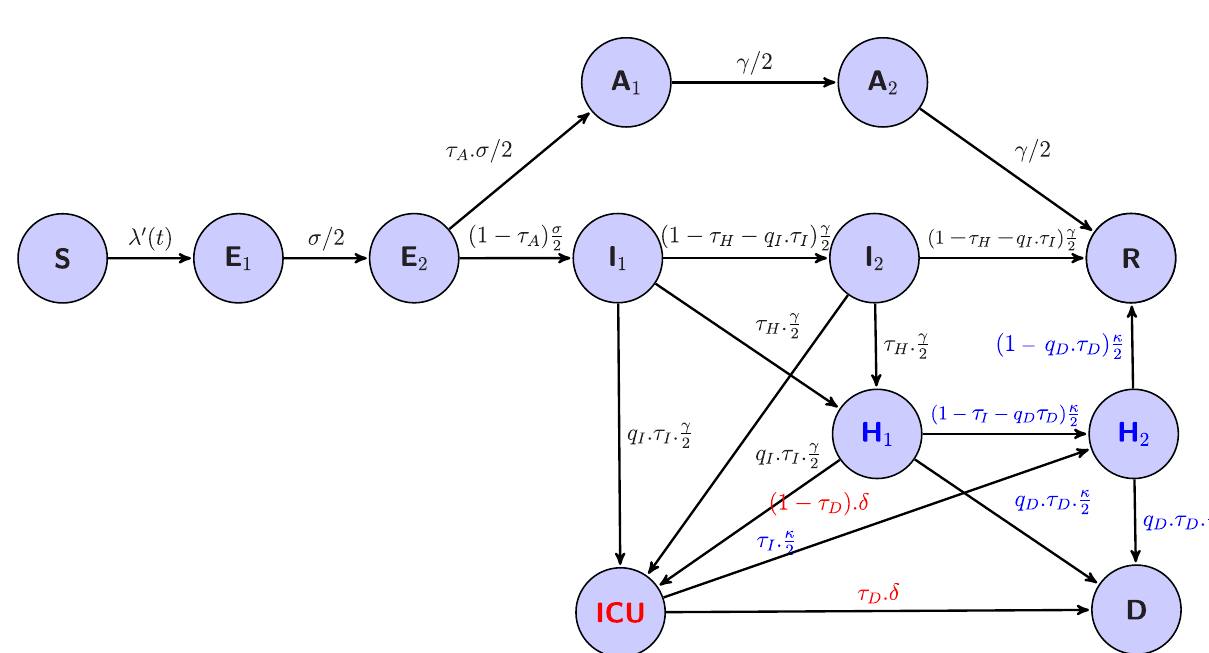
Fig 1. Flow diagram of a generalized SEIR model accounting for asymptomatic transmission and a simplified hospital system (see S2 equations in S1 Text). The variables are: the susceptibles S , the infected non-infectious E , the infectious symptomatic I , the infectious asymptomatic A , the removed individuals R , and the hospital related variables: the hospitalized individuals H , the individuals in intensive care unit ICU , and the deaths at hospital D . The subscripts 1 and 2 stand for the two stages of the Erlang distribution of the sojourn times in E , A , I , H . The flow from H 2 to R represents hospital discharge. Flows in blue are from hospital (H i ) and flow in red from ICU. λ ’(t) = β (t) . (I 1 +q 1 . I 2 +q 2 . (A 1 +A 2 ))/N then the force of infection is λ (t) = λ ’(t) . S (t) and β (t) is the time-varying transmission rate (1), σ the incubation rate, γ the recovery rate, 1/ κ the average hospitalization period, 1/ δ the average time spent in ICU, τ A the fraction of asymptomatics, τ H the fraction of infectious hospitalized, τ I the fraction of ICU admission, τ D death rate, q 1 and q 2 the reduction in the transmissibility of I and A , q the reduction in the fraction of people admitted in ICU and q the reduction in the death rate. 2 i I D